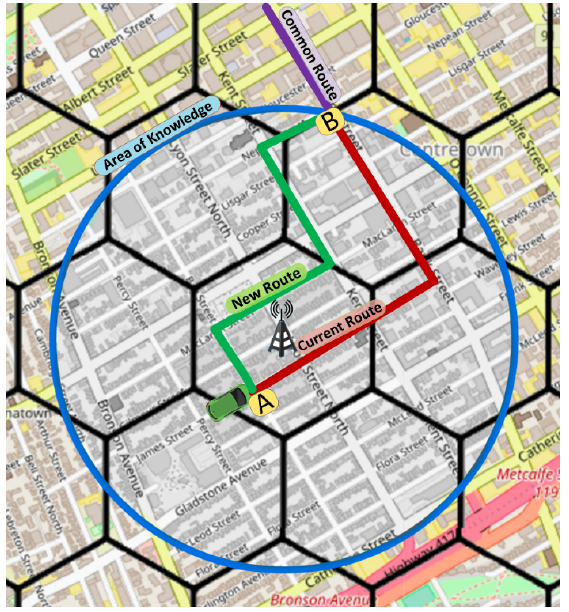
Figure 7. FOXS: Fast Offset Xpath